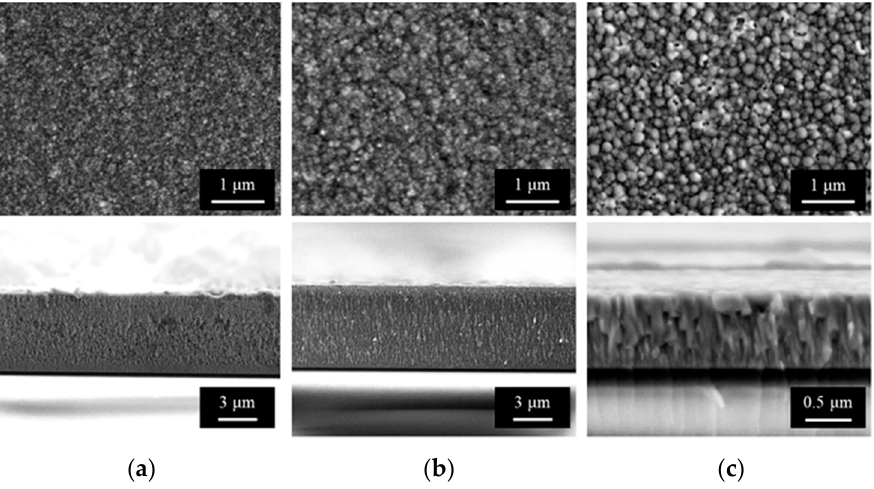
Figure 4. SEM surface (top row) and cross-section (bottom row) images of ZnO films: ( a ) m-ZnO; ( b ) Cu-ZnO; ( c ) C-ZnO. Secondary electron images were obtained using 5 kV electron acceleration voltage.